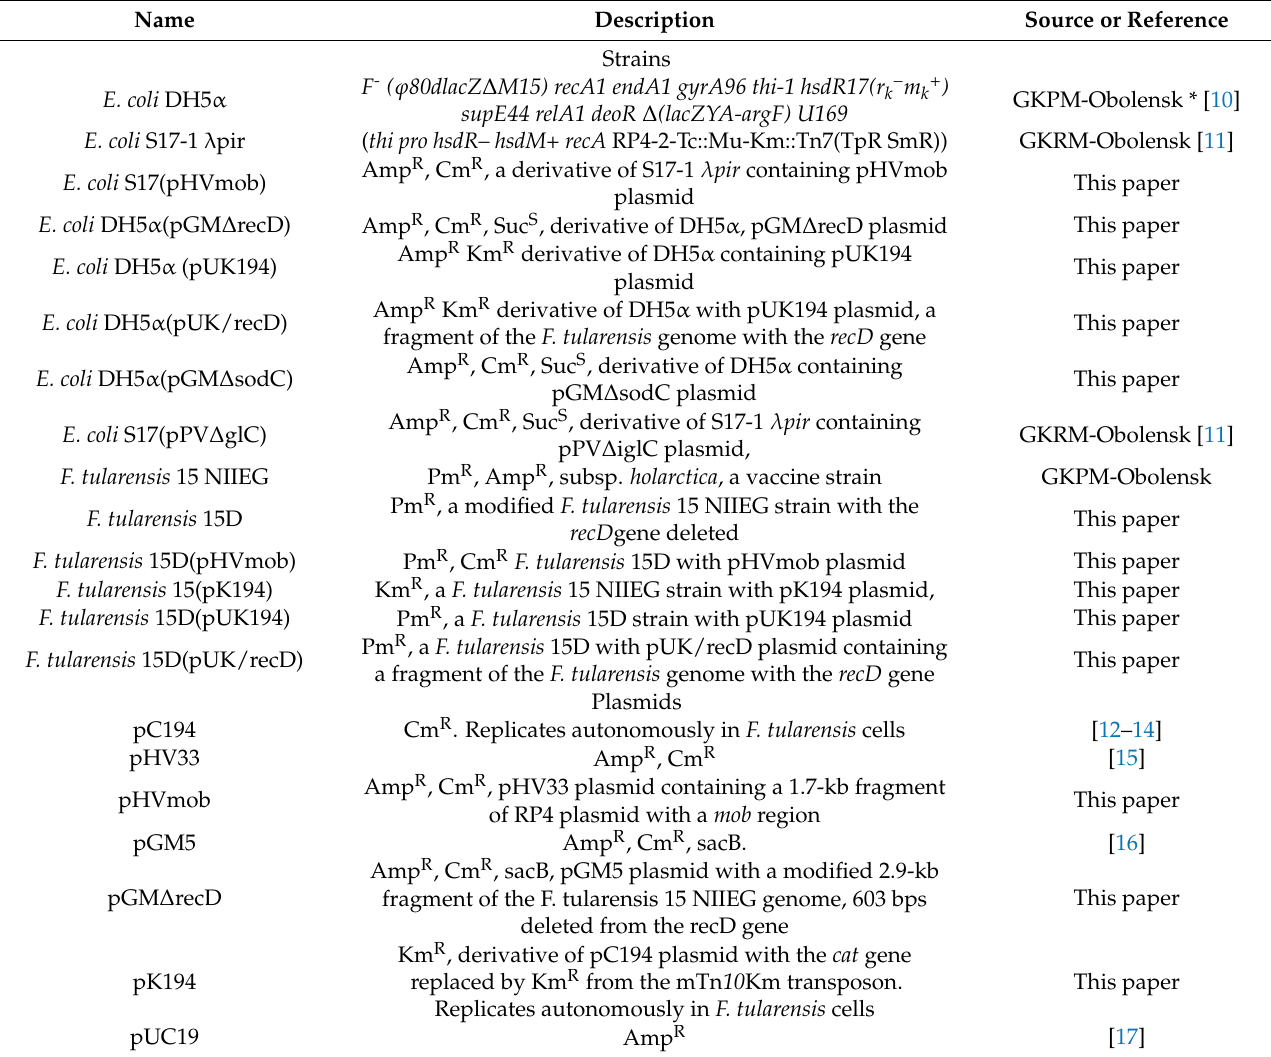
Table 1. Bacterial strains and plasmids used in this